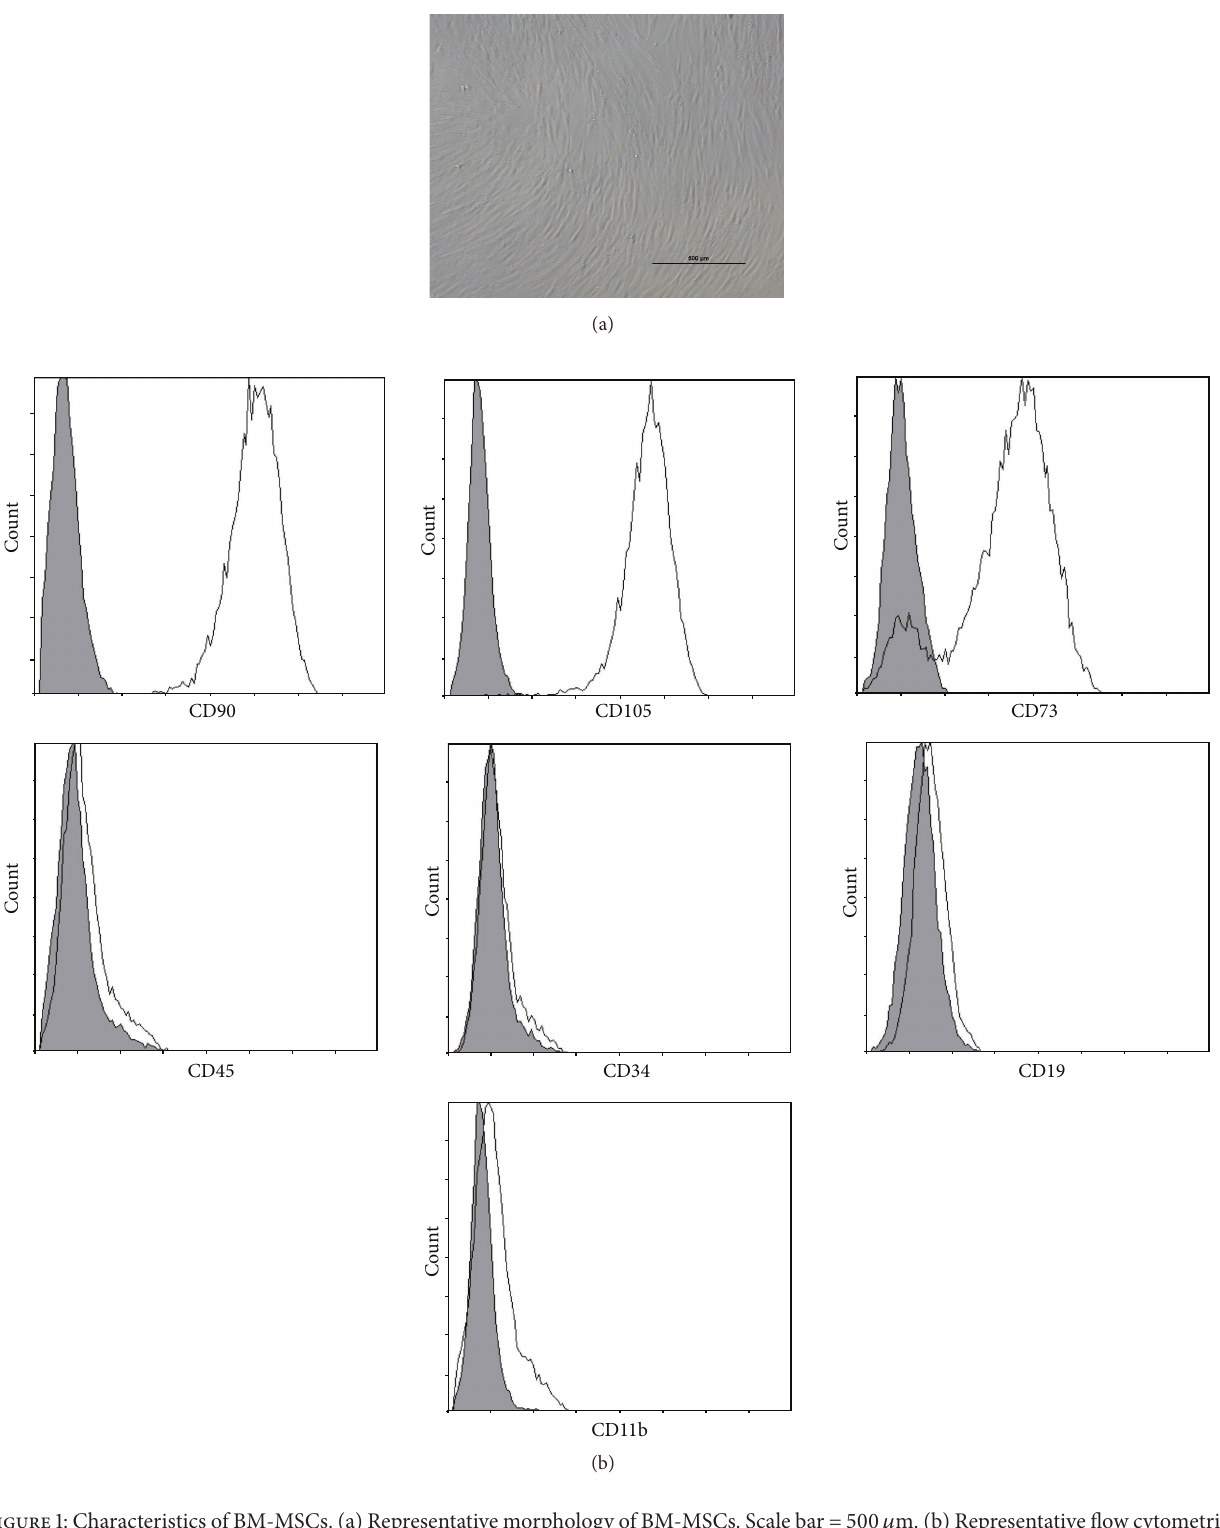
Figure 1: Characteristics of BM-MSCs. (a) Representative morphology of BM-MSCs. Scale bar = 500 𝜇 m. (b) Representative flow cytometric characterization of cell surface markers expressed on BM-MSCs. Isotypic controls were represented by the gray filled